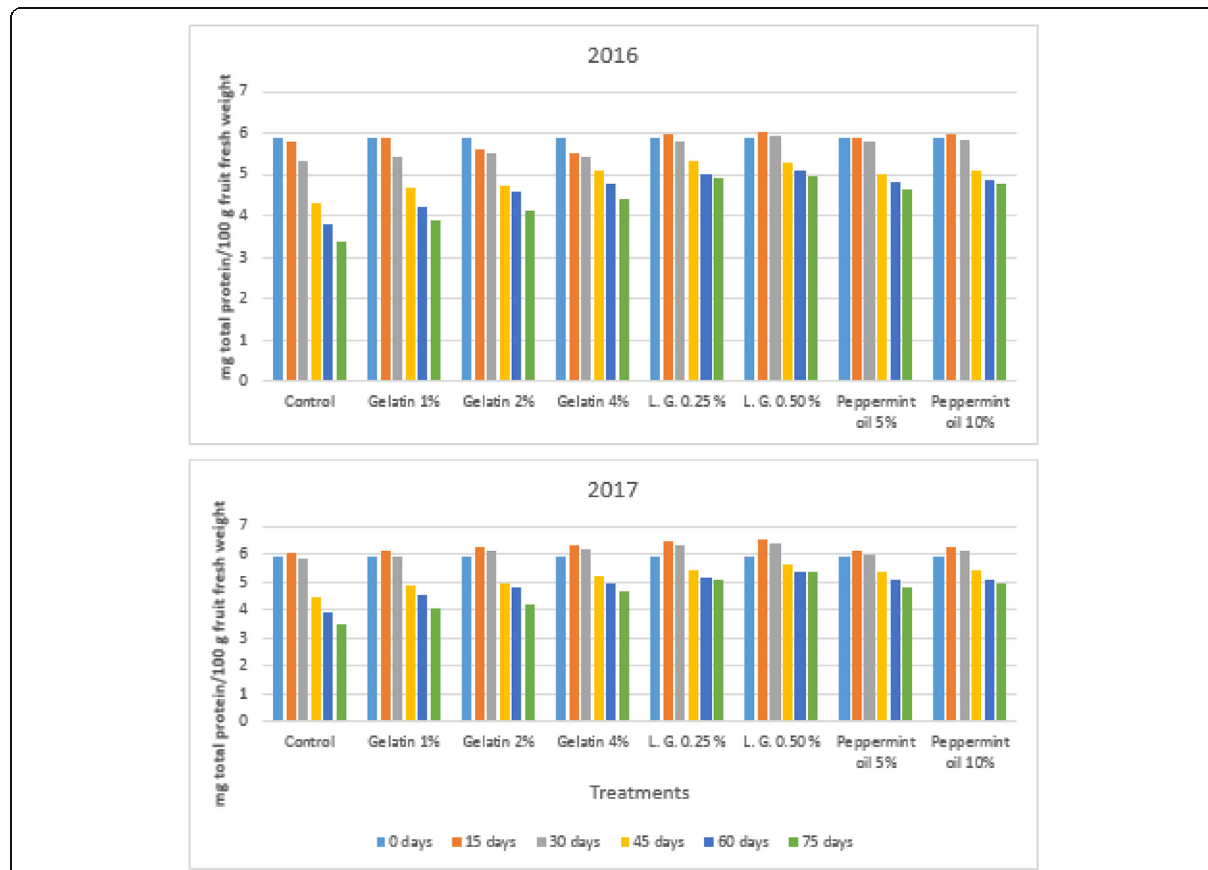
Fig. 1 Effect of gelatin, lemongrass oil and peppermint oil on fruit total protein content (mg total protein/100 g fruit fresh weight) of Samany date palm fruits stored at 0.0 °C ± 2 during two experimental